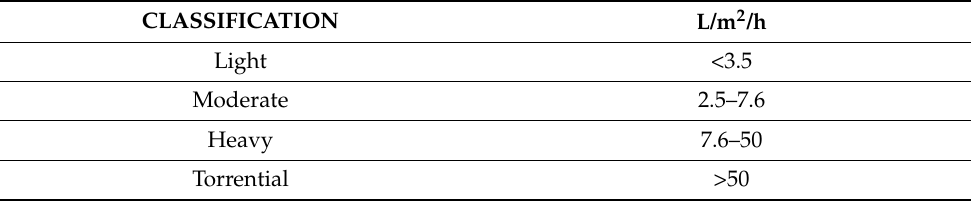
Table 5. Classification of the intensity of rainfall at any given time and place